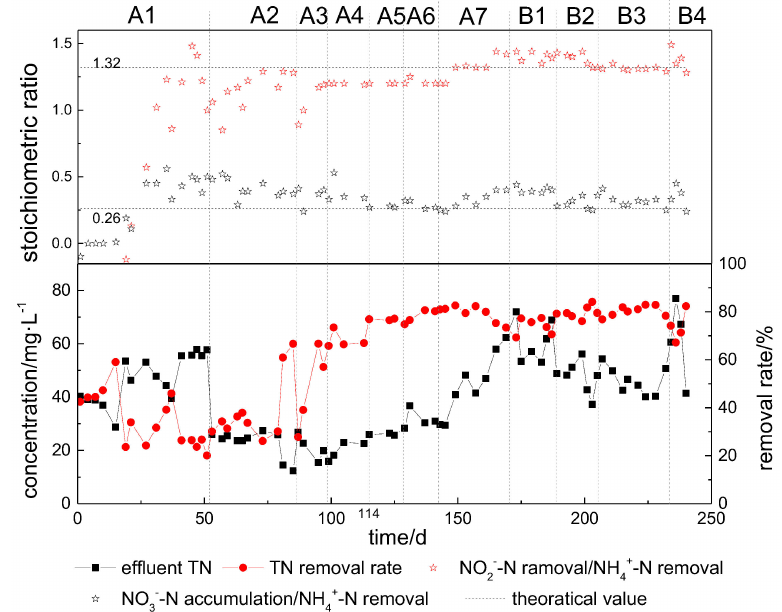
Figure 2. Total nitrogen (TN) concentration of effluent, TN removal efficiency, and stoichiometric ratios in the biofilter over the whole operation time.